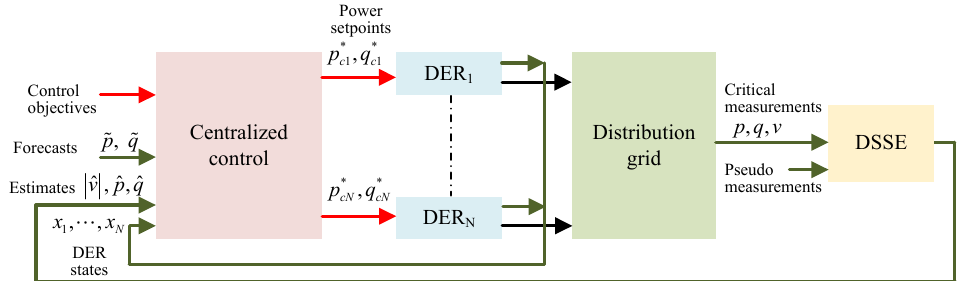
Figure 1. Schematic diagram of centralized control for demand response of distributed energy resources (DERs) based on